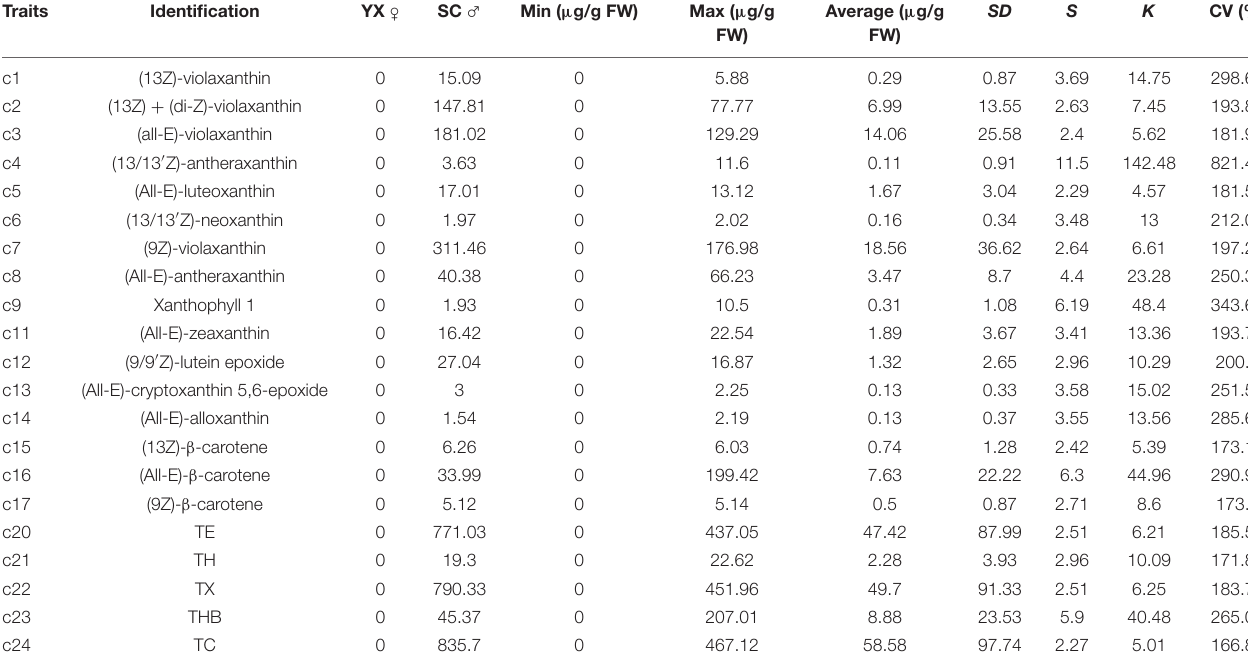
TABLE 3 | Statistical analysis of carotenoids in the petals of parents and F 1 progeny.